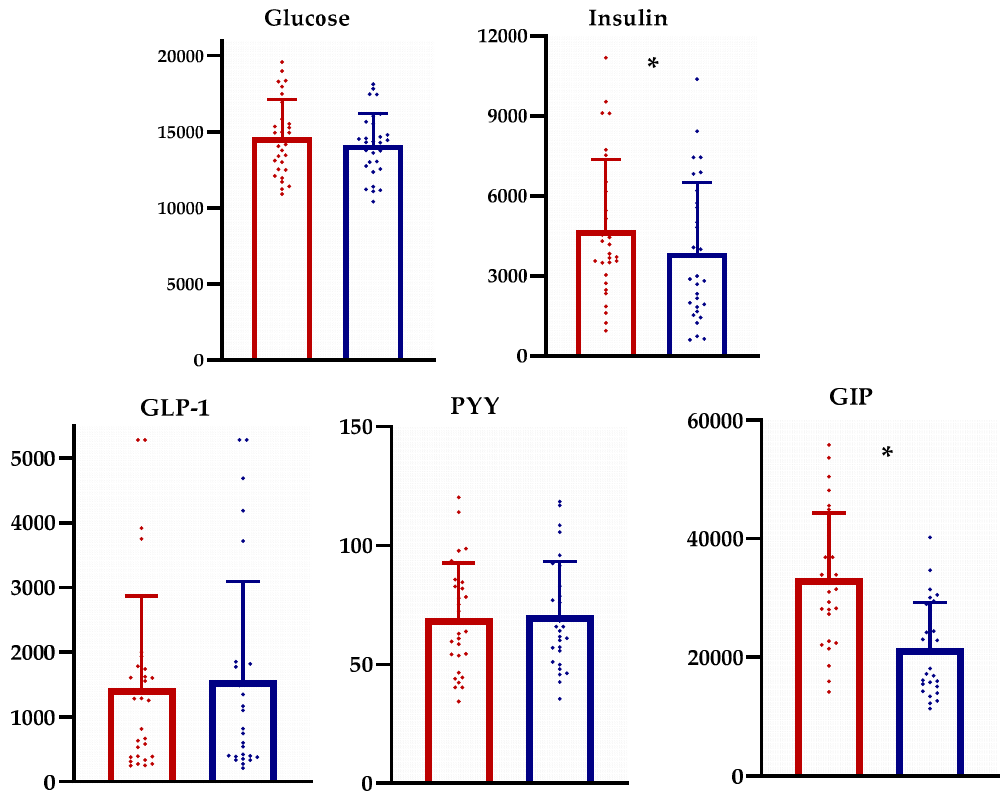
Figure 3. Comparison of the area under the curve (AUC 0–120 min ) biomarker response between boiled and chilled potato intake. * p < 0.05 between groups using non-parametric Wilcoxon Signed Ranks Test. Red color refers to the AUC (0–120 min) for the boiled potato; blue color refers to the AUC (0–120 min) for the chilled potato. GLP-1, glucagon-like peptide-1; PYY, peptide YY; GIP, glucose-dependent insulinotropic-peptide.